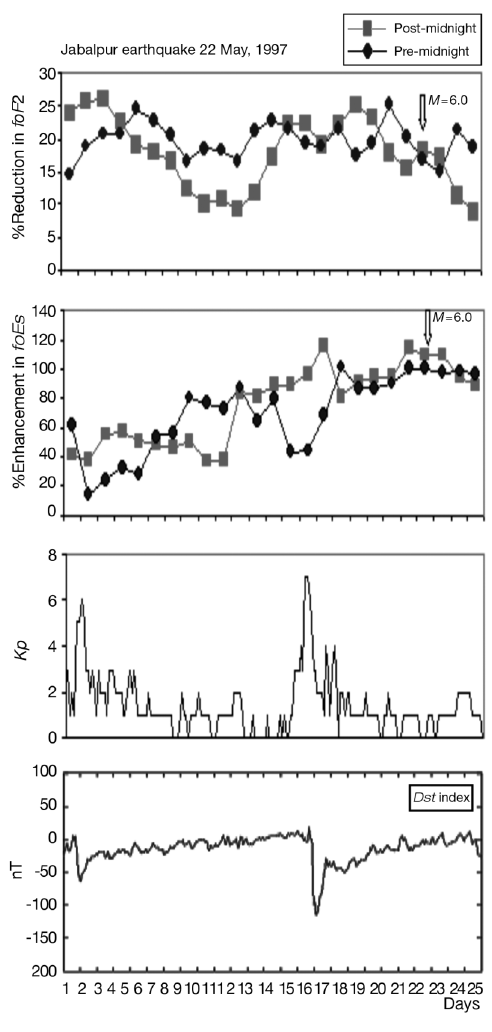
Fig. 3c. The same as fig. 3a but for Jabalpur earth- quake ( M = 6.0) which occurred on 22 May